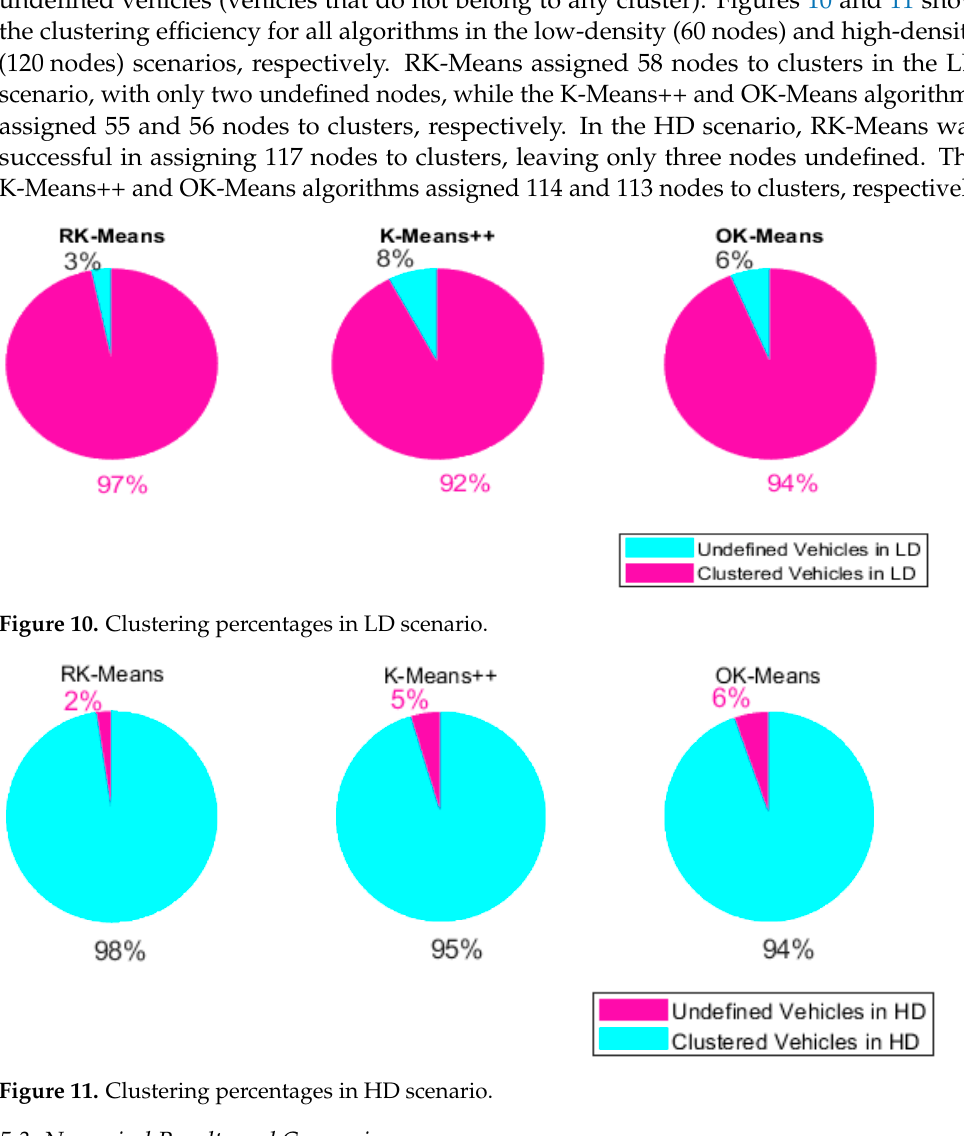
Table 6. Average cluster distribution.